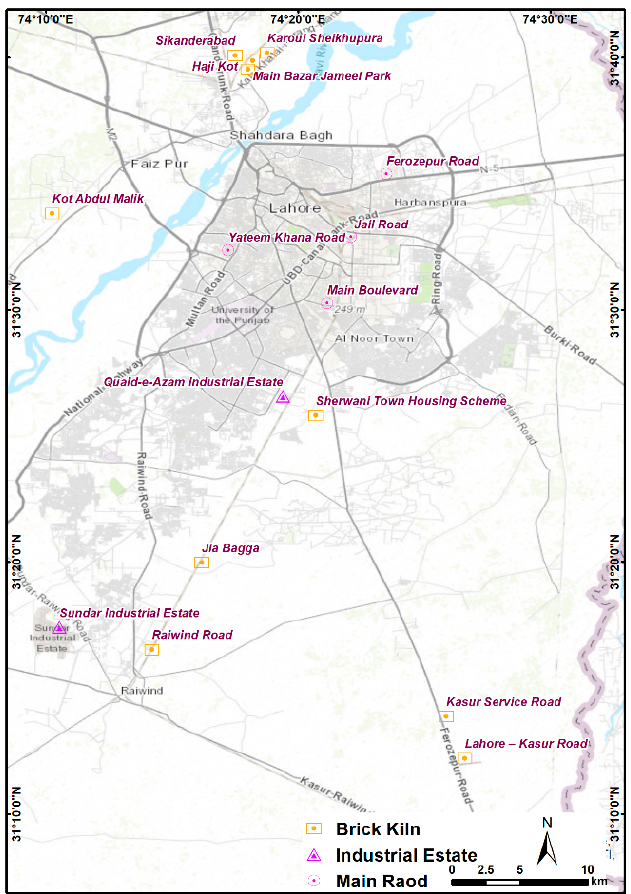
Figure 1. Study area map indicating selected sites in the Lahore district and its surrounding areas. Table 1. Location and economic activity description of selected sites.